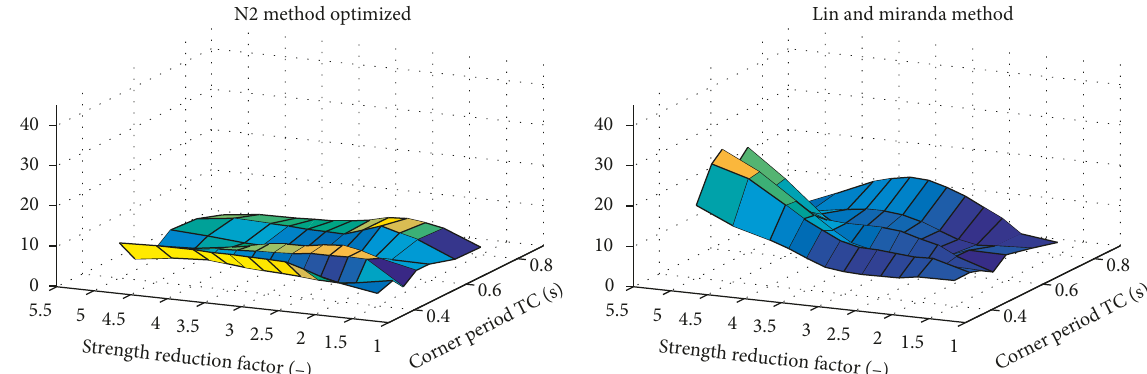
Figure 12: Overall results for the optimized N2 method (left) and Lin and Miranda method (right). The 3D surface plot of the global average discrepancy values is flat and low for the optimized N2 method, meaning that the method is all over accurate. The Lin and Miranda method shows similar trend but for low values of strength reduction factors only.